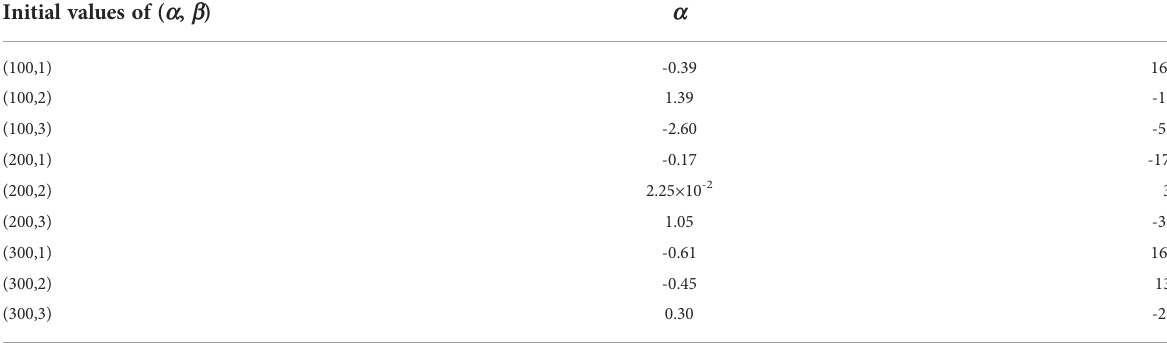
TABLE 4 Dependence of the sensitivity on the initial values of the parameters a and b . Initial values of ( a , b